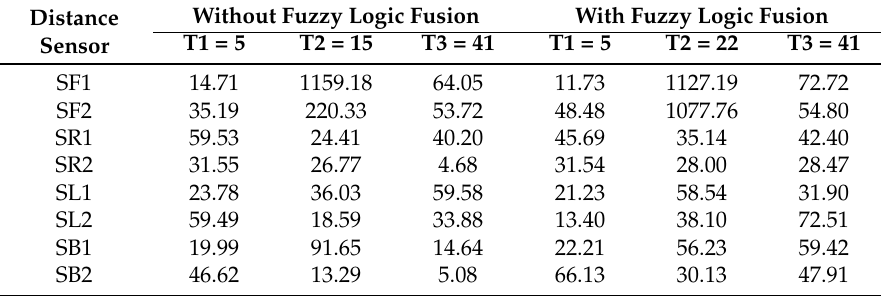
Figure 11. Real time experiment for multiple robots and obstacles. ( a ) Both robots detect obstacles; ( b ) Both robots avoid the obstacles; ( c ) Both robots return to the line; ( d ) Both robots detect each other as dynamic obstacles; ( e ) Both robots avoid each other; ( f ) Both robots have successfully avoided each other; ( g ) Both robots return to the line; ( h ) Both robots continue following the line. Table 2. Distance sensor values before and after implementing the fusion